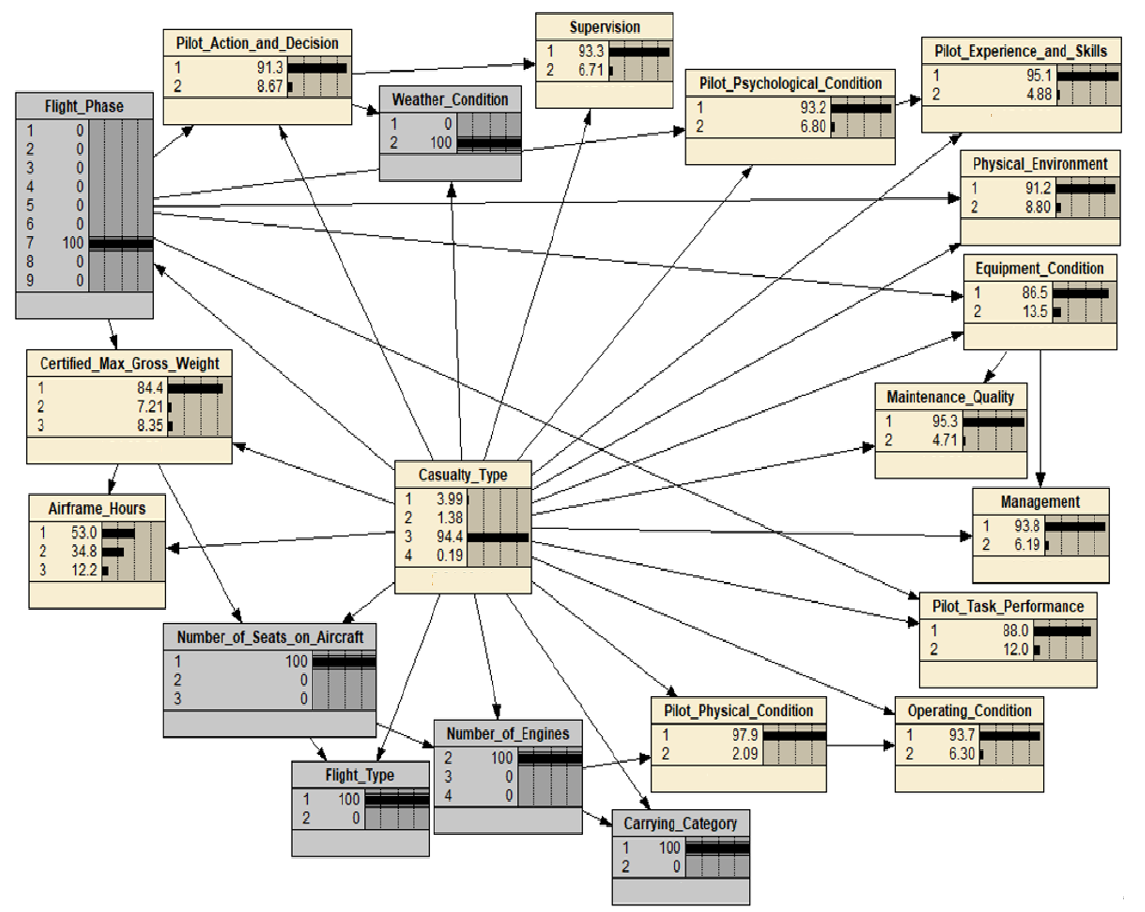
Figure 4. Model validation based on a retrospective analysis of a past civil aviation accident.